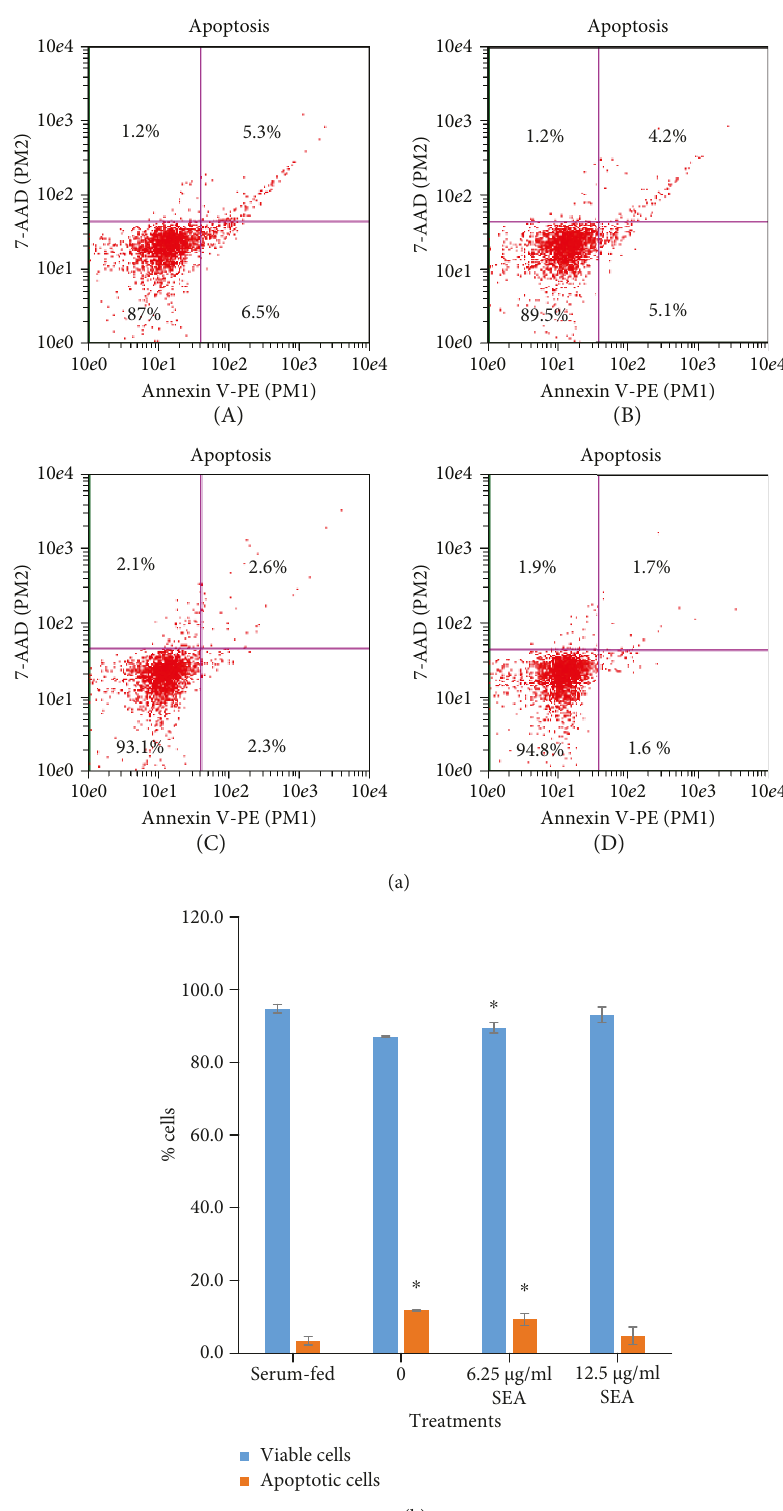
Figure 4: schSEA diminishes apoptosis in PNT2 cells. (a) (A) Negative control, (B) 6.25 μ g/ml schSEA, (C) 12.5 μ g/ml schSEA, and (D) serum-fed (positive control). Lower left quadrant: viable cells; lower right quadrant: early apoptotic cells; upper left quadrant: nuclear debris; upper right quadrant: late apoptotic cells. Data was acquired by Guava EasyCyte ™ fl ow cytometer. (b) Comparison of apoptosis and cell viability among various experimental groups. Statistical signi fi cance by Student ’ s t -test: ∗ p ≤ 0 05 (serum-fed vs. serum-starved/ schSEA-treated groups). Results are representative of three independent